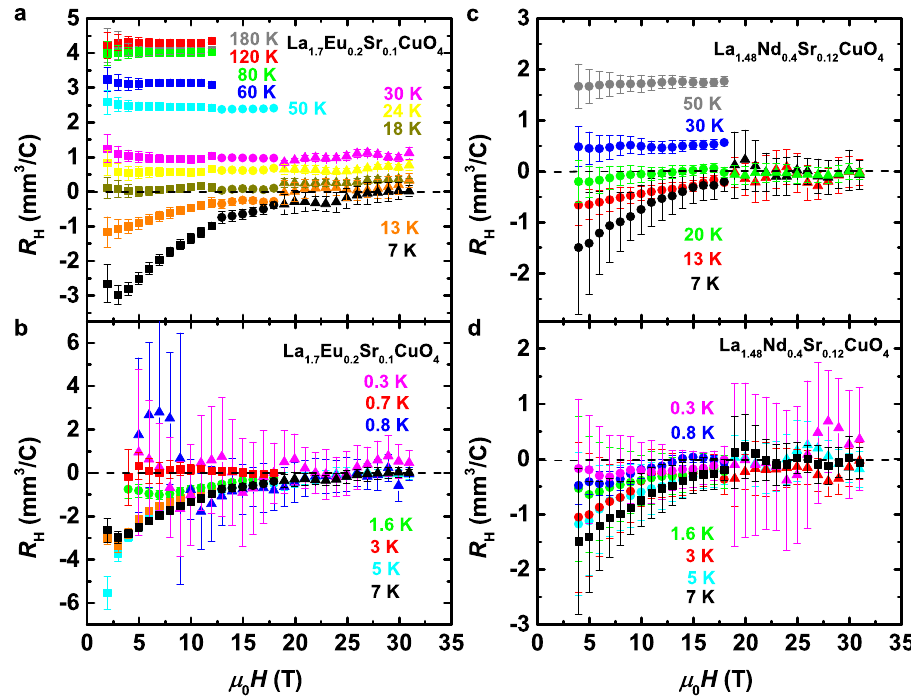
Fig. 2 Field dependence of the Hall coef fi cient R H at various temperatures. Higher- and lower- T data for La 1.7 Eu 0.2 Sr 0.1 CuO 4 are shown in a and b , respectively, i.e., in c and d for La 1.48 Nd 0.4 Sr 0.12 CuO 4 . Different symbols, corresponding to the data taken in different magnet systems, show good agreement between the runs. The data points represent R H values averaged over 1 T bins (Supplementary Fig. 3), while error bars correspond to ± 1 SD (standard deviation) of the data points within each bin. The error bars are typically larger at lower T resulting from the use of lower excitation currents I (see Methods) necessary to avoid heating and to ensure that the measurements are taken in the I → 0 limit, because of the strongly nonlinear (i.e., non- Ohmic) transport in the presence of vortices 3 . At higher T , the error bars are 3-4 times smaller, Δ R H ~ 0.2 − 0.3 mm 3 /C (see also Supplementary Fig. 3). However, similar Δ R H , and even Δ R H ~ 0.05 mm 3 /C, have been achieved also at low T , as described in Methods (see also Supplementary Fig. 4). At high T , R H , but it decreases to zero at T = T H ) upon cooling. As T is reduced further, R H , within the VL regime H is independent of 0 ( H becomes negative for lower [ H < H c2 ( T )]. In the normal state [ H > H c2 ( T )], however, R H ≈ 0 down to the lowest T ; Δ R H ~ 0.05 mm 3